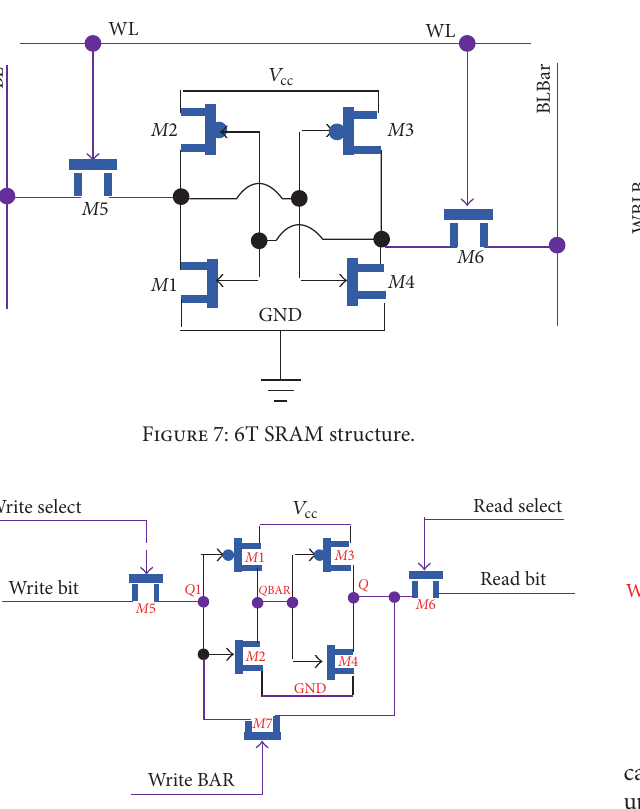
Figure 8: 7T SRAM structure.